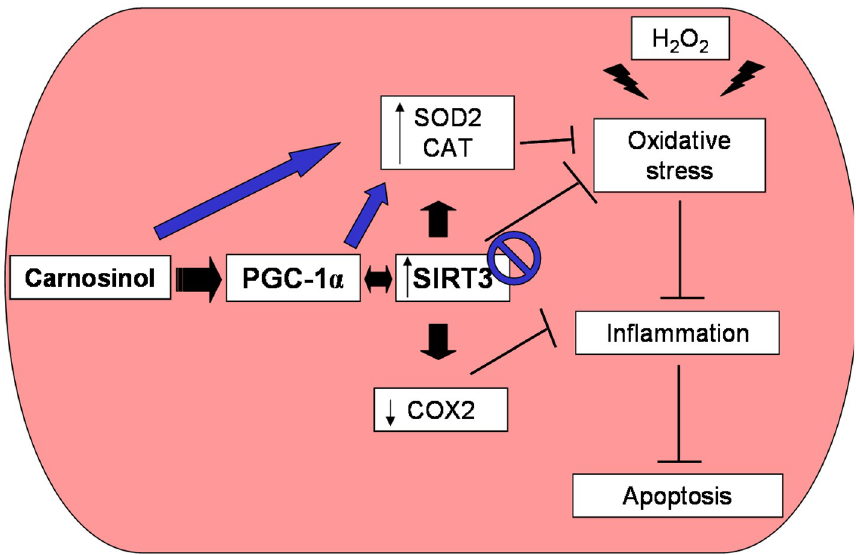
Fig 8. Carnosinol therapeutic potentials. Schematic representation of the therapeutic protective antioxidative effects of carnosinol against hydrogen peroxide-mediated alterations at myotube level showing that carnosinol may act through the mitochondrial PGC-1 α /SIRT3 signaling pathway (black arrows), but if SIRT3 is inhibited carnosinol’s effects are not blocked (blue arrows). H 2 O 2 : hydrogen peroxide; CAT: catalase; COX2: cyclooxygenase2; PGC-1 α : peroxisome proliferator-activated receptor gamma coactivator-1alpha; SIRT3: sirtuin3; SOD2: superoxide dysmutase2.